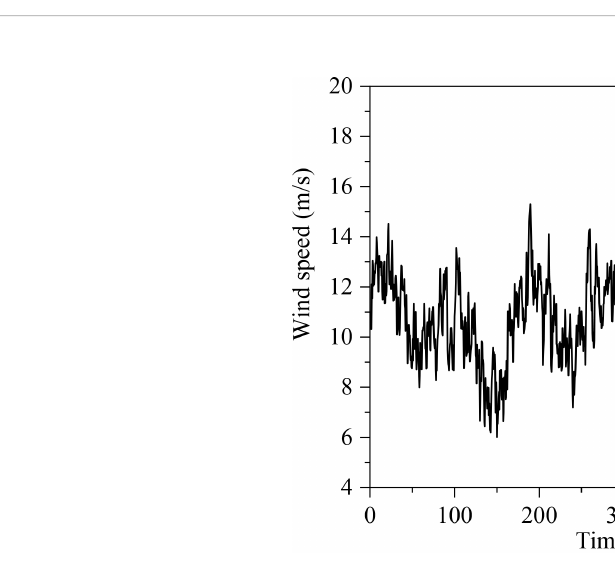
FIGURE 8 Synthesized stochastic wind speeds based on IEC Kaimal turbulence